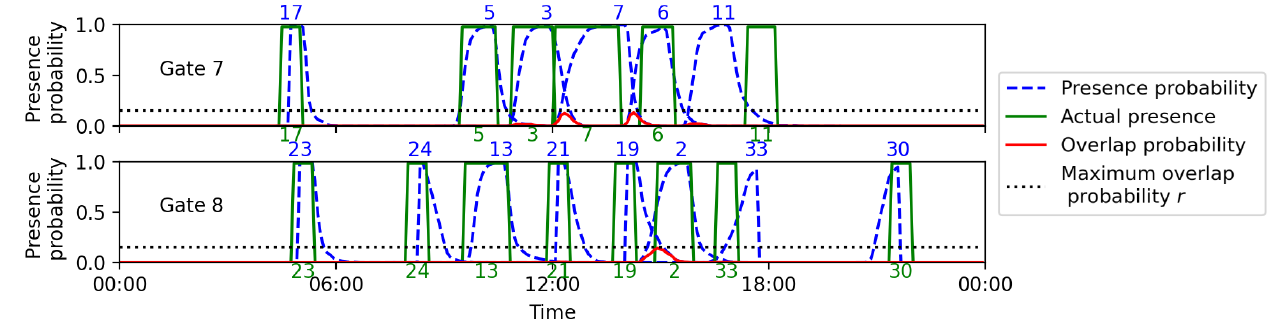
Figure 11. Flight-to-gate assignment for gates 7 and 8 on 14 July 2019 obtained using the probabilistic model with maximum overlap probability r = 0.15 combined with actual aircraft